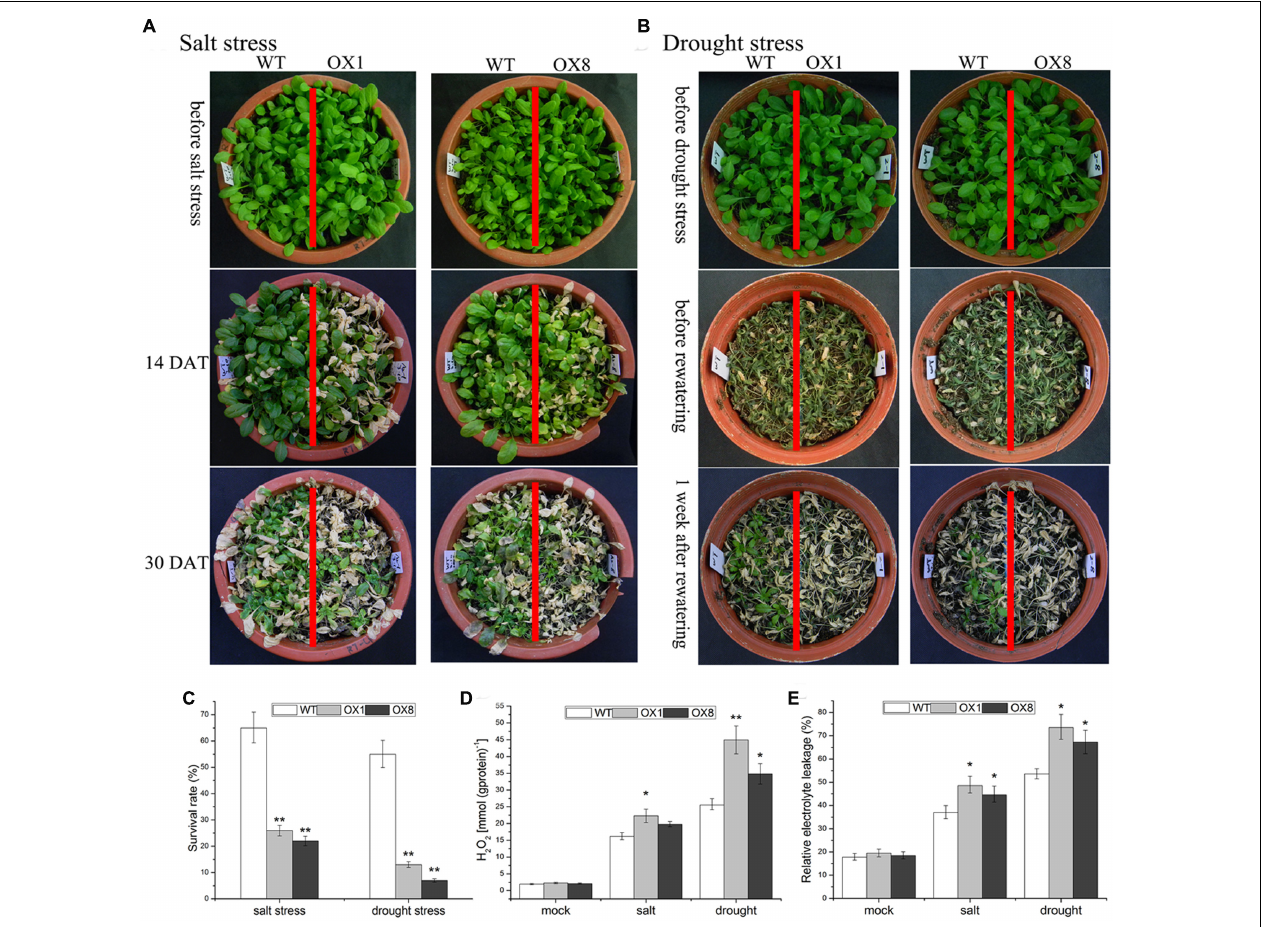
FIGURE 3 | Hypersensitivity of TaNAC2D -OX plants to salt and drought stresses. (A) The 35-day-old WT and TaNAC2D -OX plants were irrigated with 200 mM NaCl for 30 days. (B) The 35-day-old WT and TaNAC2D -OX plants were subjected to drought stress for 20 days and then re-watered for 1 week. (C) Survival rate of WT and TaNAC2D -OX plants. (D,E) Plants were subjected to salt stress for 10 days and drought stress for 17 days, H 2 O 2 content and relative electrolyte leakage were determined. Data in (C–E) are means ± SE of three biological replicates. Asterisks indicate significant differences from control ( ∗ P < 0.05, ∗∗ P <